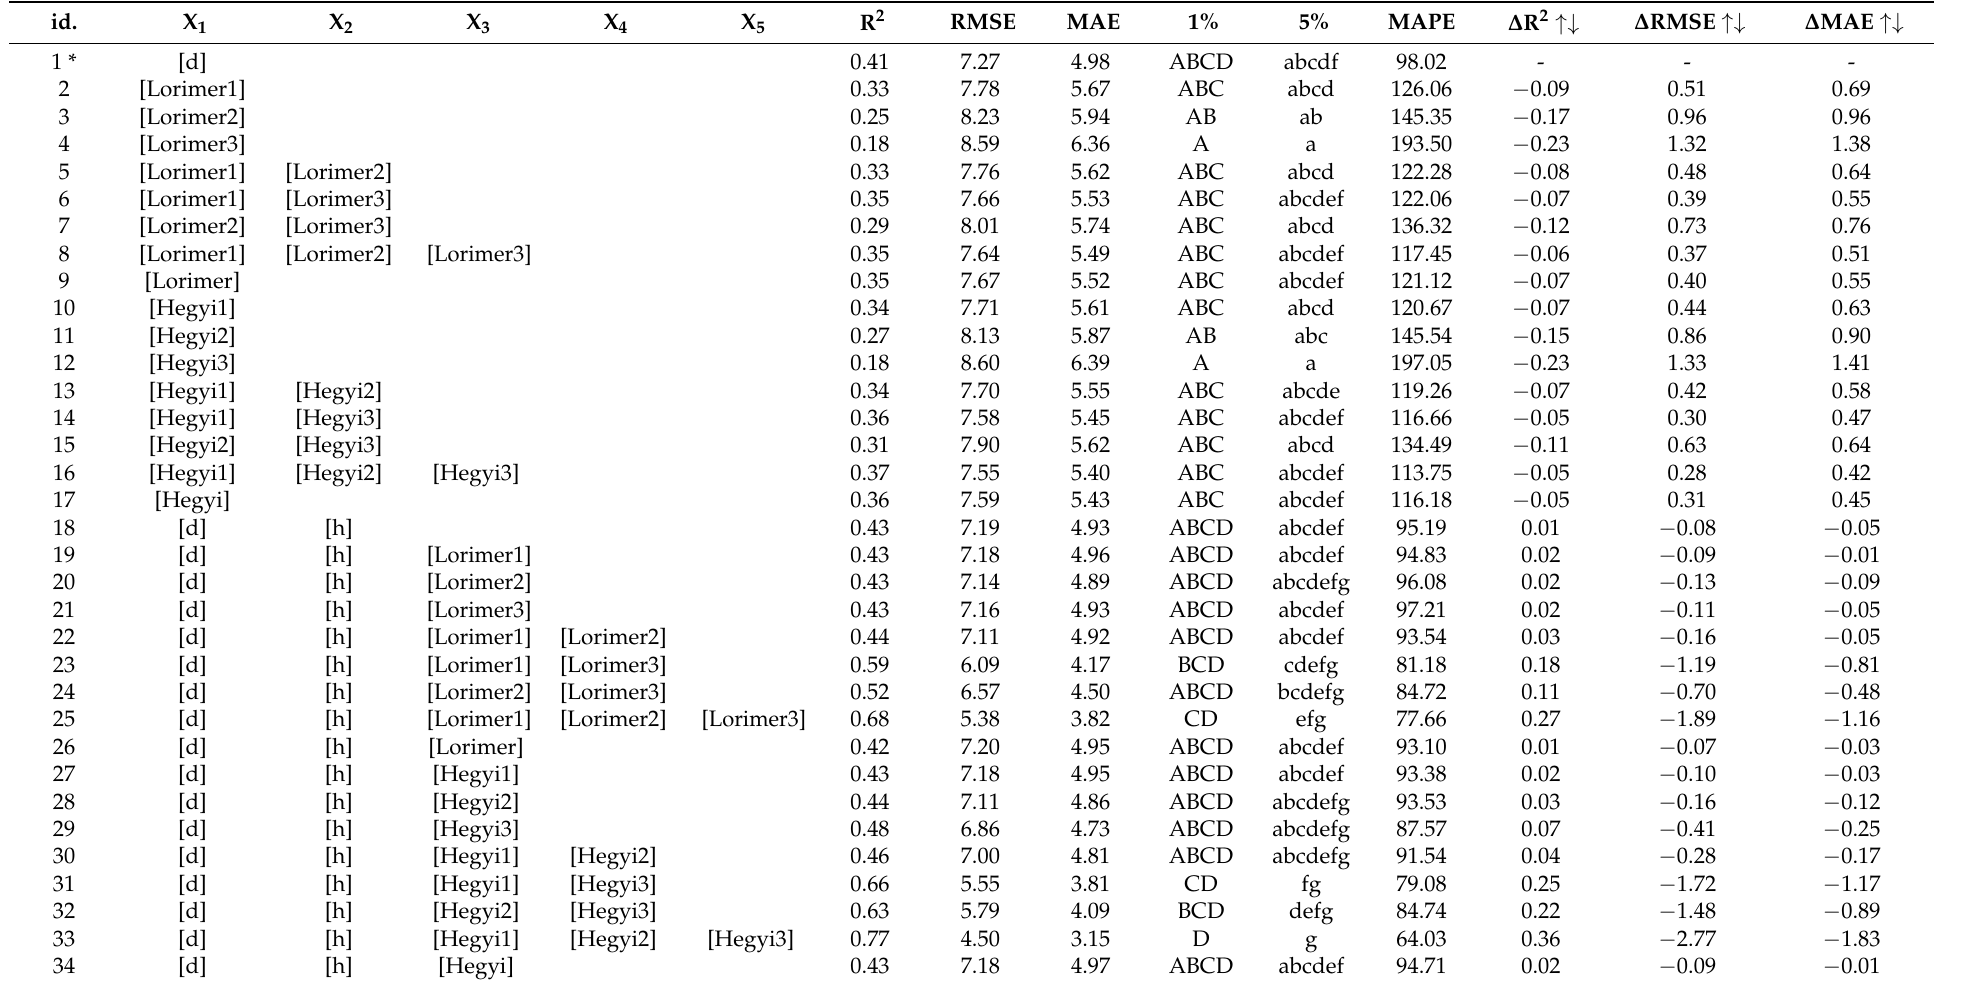
Table 6. Artificial neural networks and statistics of precision and accuracy of BAI models for A. angustifolia in a Mixed Ombrophilous Forest in Southern